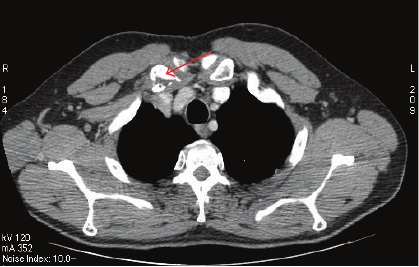
Figure 2: Partial response after radiotherapy and 10 months of imatinib with partial reossification in the sternoclavicular joint and decreasing of the soft tissue extension.